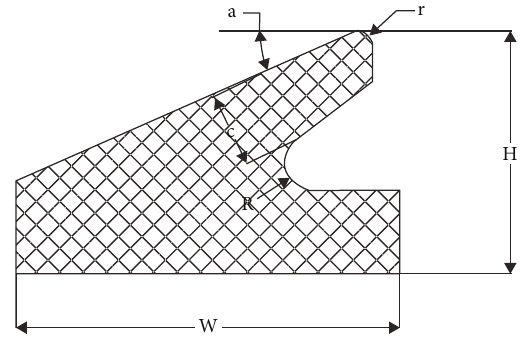
Figure 30: Optimized parameter position of the rubber